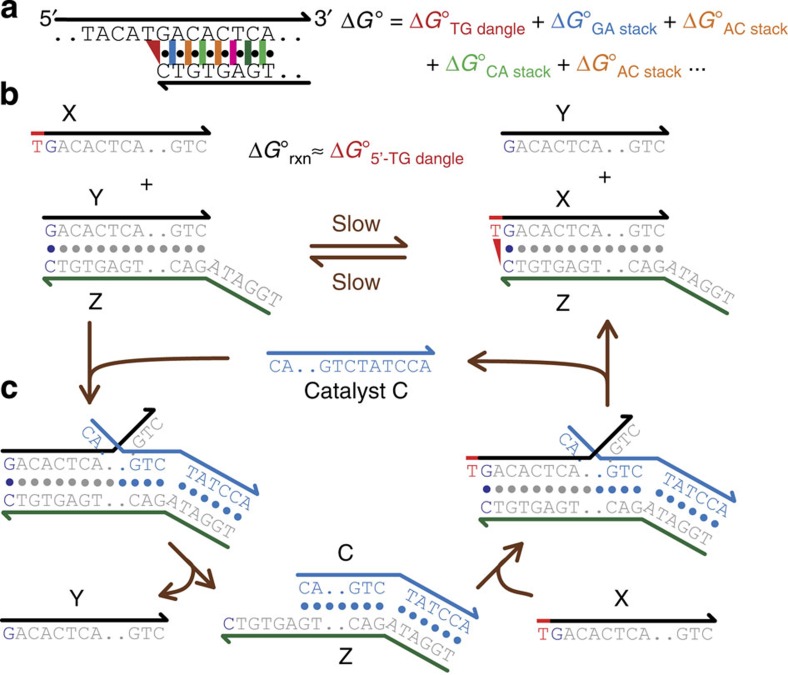
DNA hybridization thermodynamics.(a) The standard model of nucleic acid hybridization decomposes any nucleic acid molecule into a number of non-overlapping motifs (for example, dangles and stacks), and predicts the standard free energy of formation of the molecule to be the sum of the ΔG° of the individual motifs. Traditionally, motif ΔG° values are characterized using melt curves, and then extrapolated to other temperatures and buffer conditions. (b) In principle, motif ΔG° can be measured in native isothermal conditions by observing the equilibrium concentrations of an appropriately designed  strand displacement reaction. For example, the shown reaction characterizes the ΔG° of the 5′-T dangle next to a closing G–C base pair; the partially double-stranded product differs from the partially double-stranded reactant by only the motif of interest. By designing the single-stranded reactants to possess negligible secondary structure, the reaction standard free energy  will closely approximate the dangle standard free energy . (c) A non-covalent strand displacement catalyst C can be designed to accelerate reaction equilibration to complete within minutes. The reverse reaction pathway is analogous to the forward reaction pathway shown here, and is also accelerated by the catalyst.